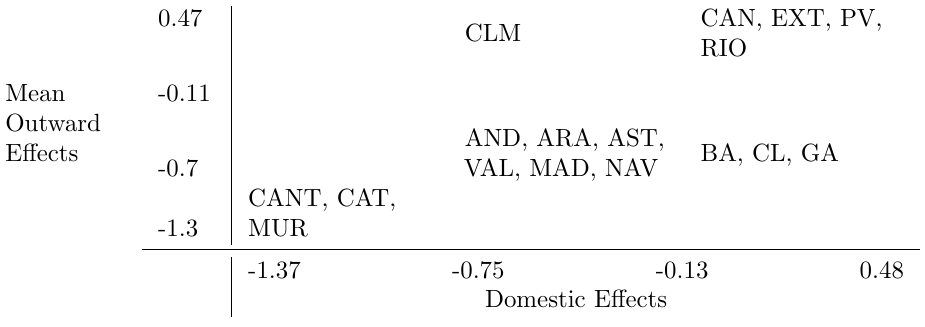
Table 6: Regional taxonomy: Domestic Effects versus Mean Inward